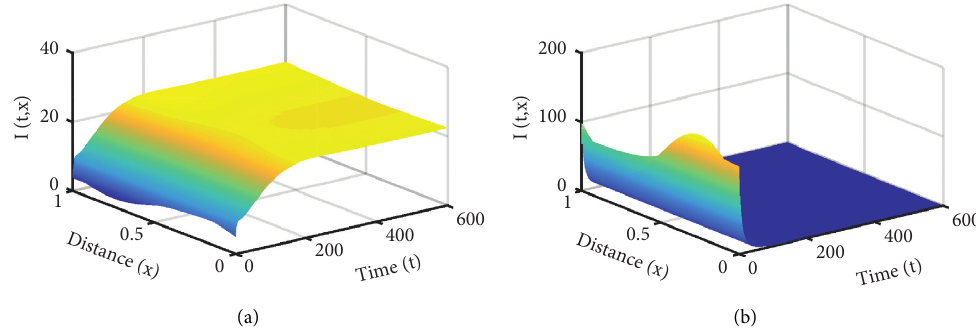
Figure 1: The time evolution of the densities of I ( t,x ) for different R